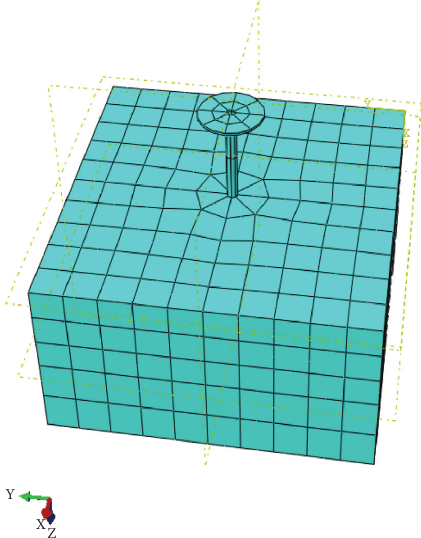
Figure 10: Anchor bolt drawing